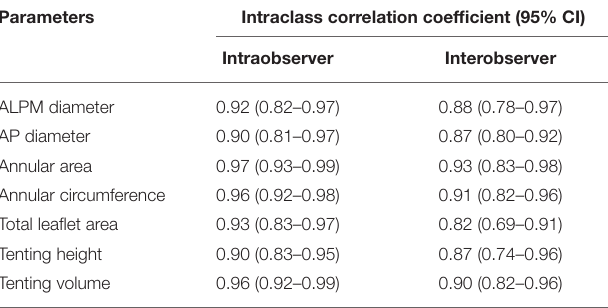
TABLE 4 | Intraobserver and interobserver variabilities of MVN